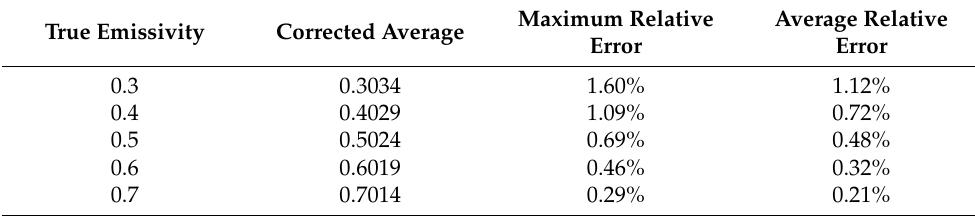
Figure 12. Corrected emissivity calculation results. The average value, maximum relative error, and average relative error of the cor- rected emissivity measurement results are shown in Table 3. Table 3. Average value and maximum and average relative errors of corrected emissivity.